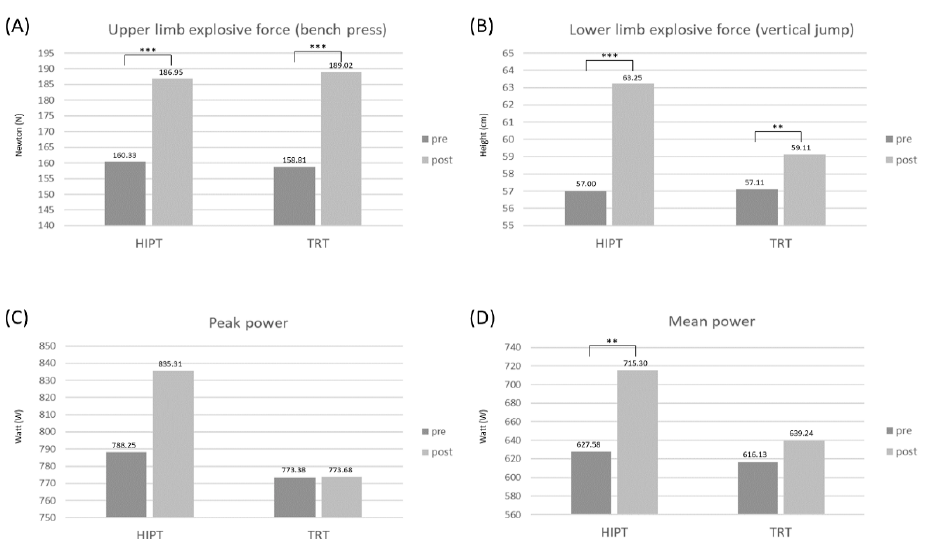
Figure 3. The results of pretest and post-test (after 8 weeks of training) of HIPT and TRT groups. ( A ) Bench press, ( B ) vertical jump, ( C ) peak power output in Wingate anaerobic test, and ( D ) mean power output in Wingate anaerobic test. ** p < 0.01, *** p < 0.001.